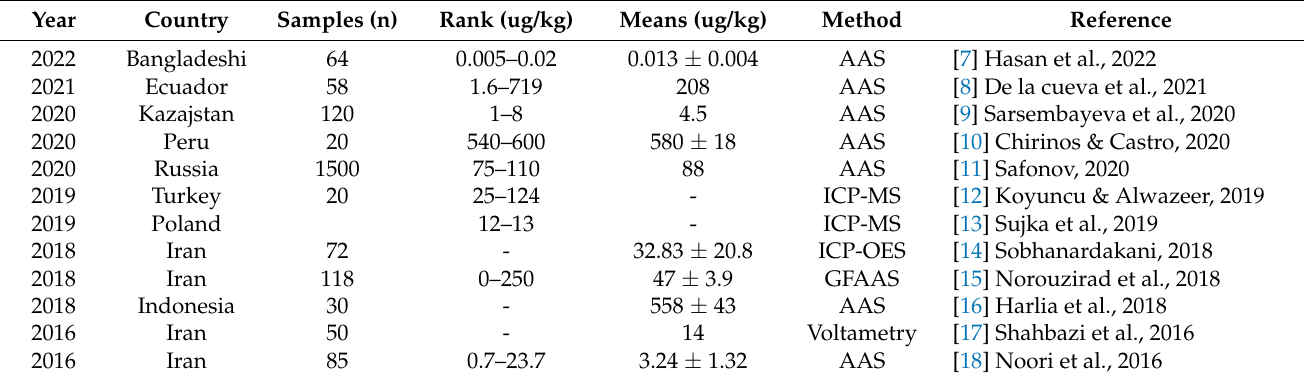
Table 1. Pb content in whole milk samples from various countries (2016–2022).